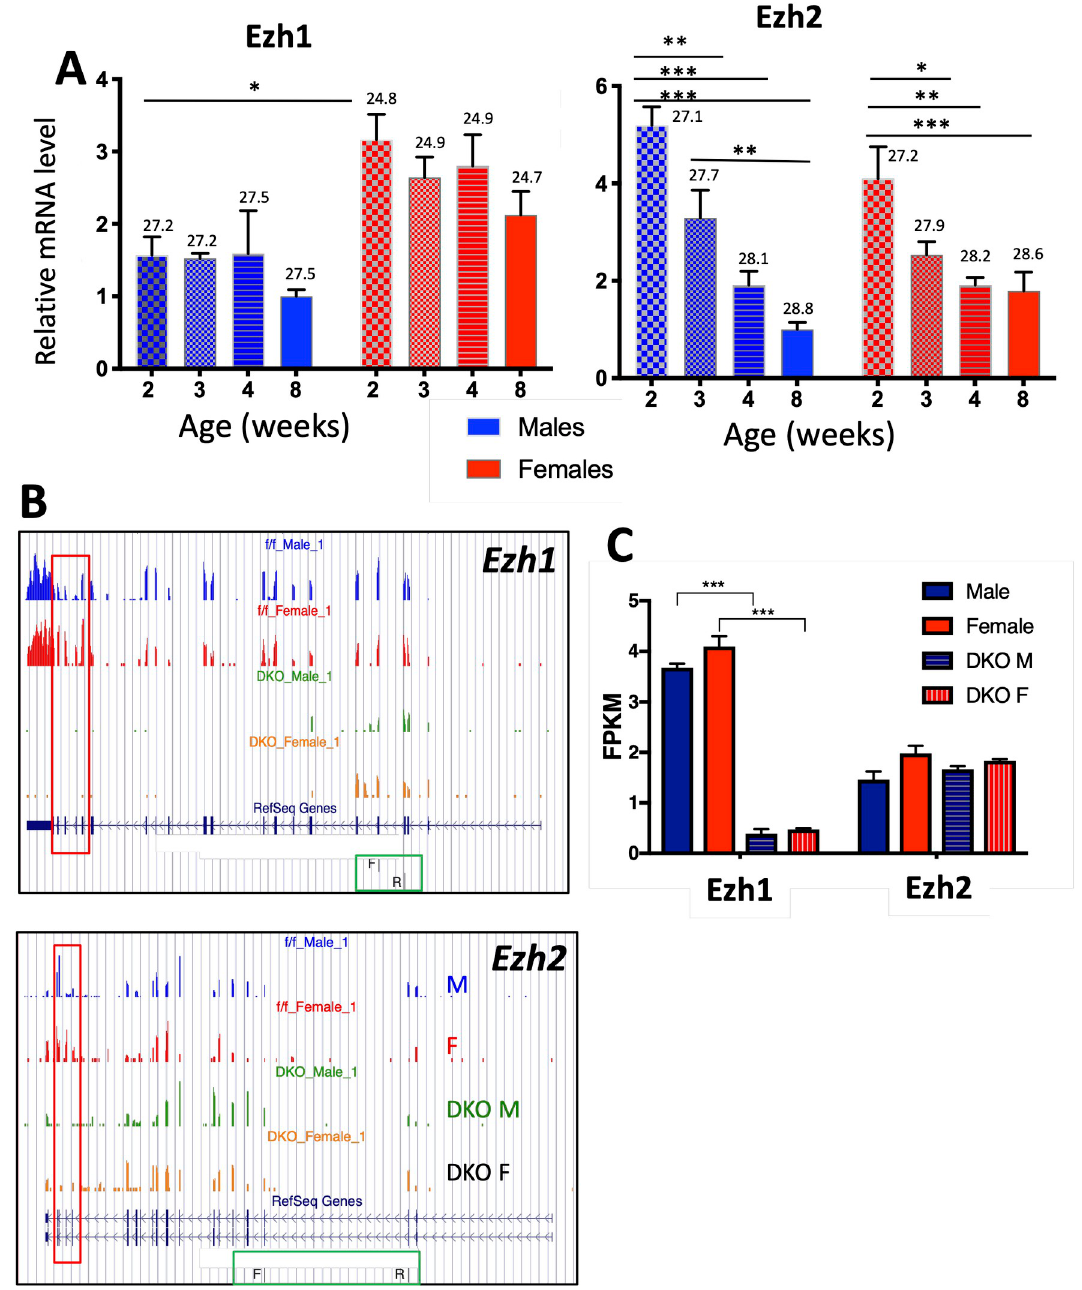
Fig 1. Ezh1 and Ezh2 expression in wild-type pre-pubertal and young adult liver and in E1/E2-KO mouse liver. ( A ) Relative expression levels of Ezh1 and Ezh2 determined by RT-qPCR in male and female mouse livers at 2, 3, 4 and 8 weeks of age. Data shown are mean ± SEM for n = 3 ( Ezh1 ) or n = 6 ( Ezh2 ) individual livers per group. Primers used are shown in S1A Table and their location marked with green boxes in Fig 1B. Significance values by 2-way ANOVA with Tukey’s or Sidak’s multiple comparisons test are indicated: � p < 0.05; �� p < 0.01 and ��� p < 0.001. qPCR cycle threshold numbers (Ct values) are shown above each bar. ( B ) UCSC genome browser screenshots of RNA-seq BigWig tracks evidencing the absence in 7-week male and female E1/E2-KO livers of Ezh1 and Ezh2 sequence reads from several exons, including those that code for the SET domain ( Ezh1 exons 17–21 and Ezh2 exons 16–19; red boxes ). ( C ) In the case of Ezh1 , but not Ezh2 , gene disruption leads to a significant decrease in overall normalized sequence reads, shown in units of FPKM. Data are mean ± SEM values for n = 3 individual livers per group. Significance values represent FDR values determined by EdgeR, ��� p < 0.001. DKO, Ezh1/Ezh2 double knockout male (M) and female (F) mouse liver.